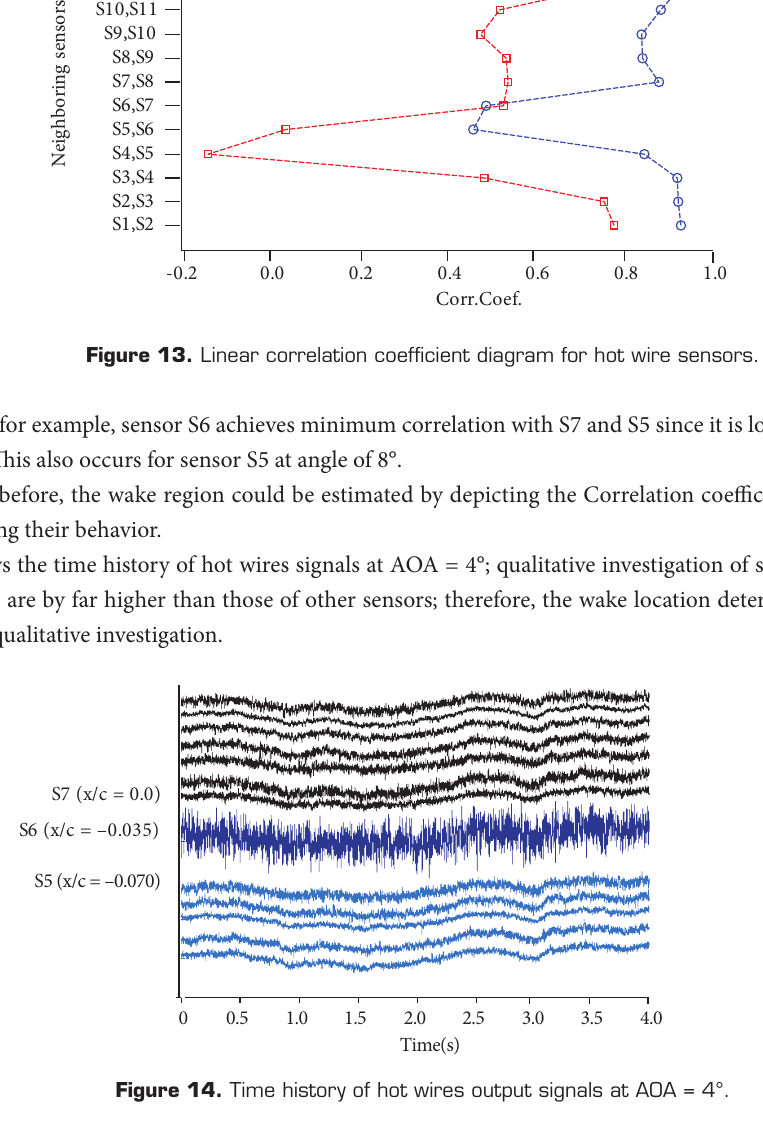
Figure 13 indicates linear correlation coefficient diagram for hot wire sensors. Correlation coefficient is a value between +1 and −1 calculated so as to represent the linear interdependence of two variables or sets of data. Therefore, in this research, correlation coefficient between two adjacent sensors shows the flow behavior at sensor locations. As it is shown in Fig. 13, the coefficient is maximized for a couple of sensors located outside the wake and decreases when they are not at the same region (i.e., one sensor locates inside the wake region and the other locates outside).